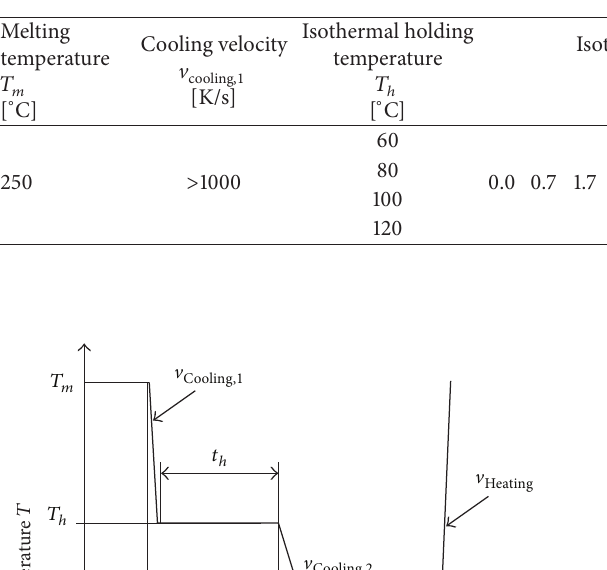
Table 1: Temperature-time profiles analyzed by FSC.